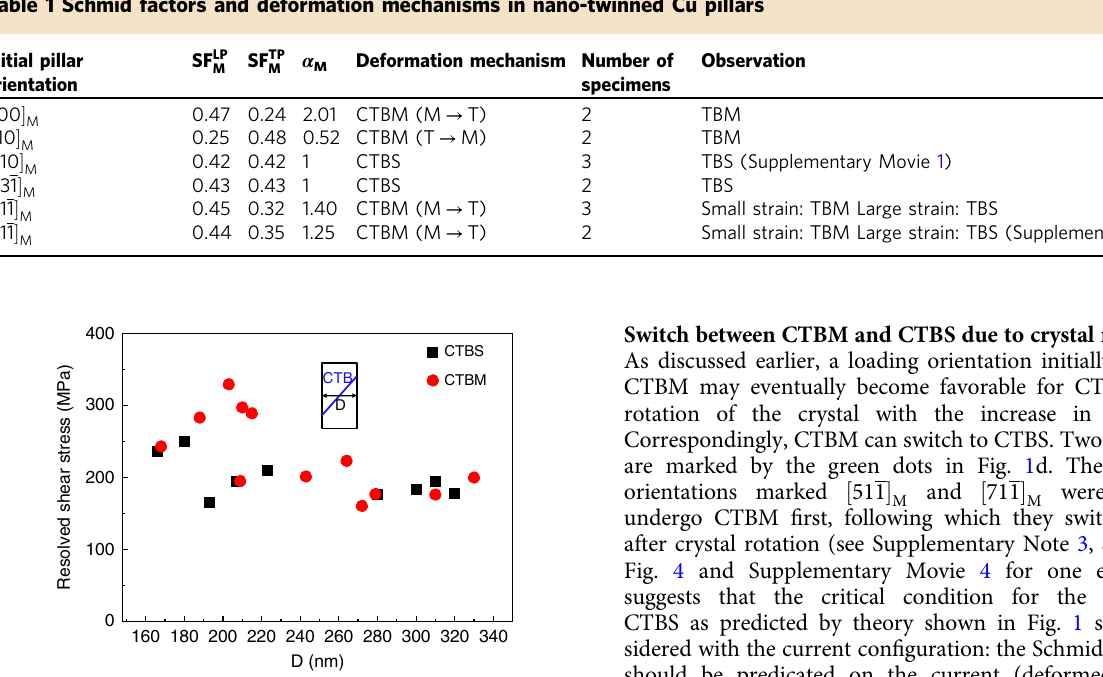
Fig. 4 Critical resolved shear stress for coherent twin boundary sliding and coherent twin boundary migration. Experimentally determined values for the onset of coherent twin boundary sliding (CTBS) and coherent twin boundary migration (CTBM) for copper nanopillars of various diameters,